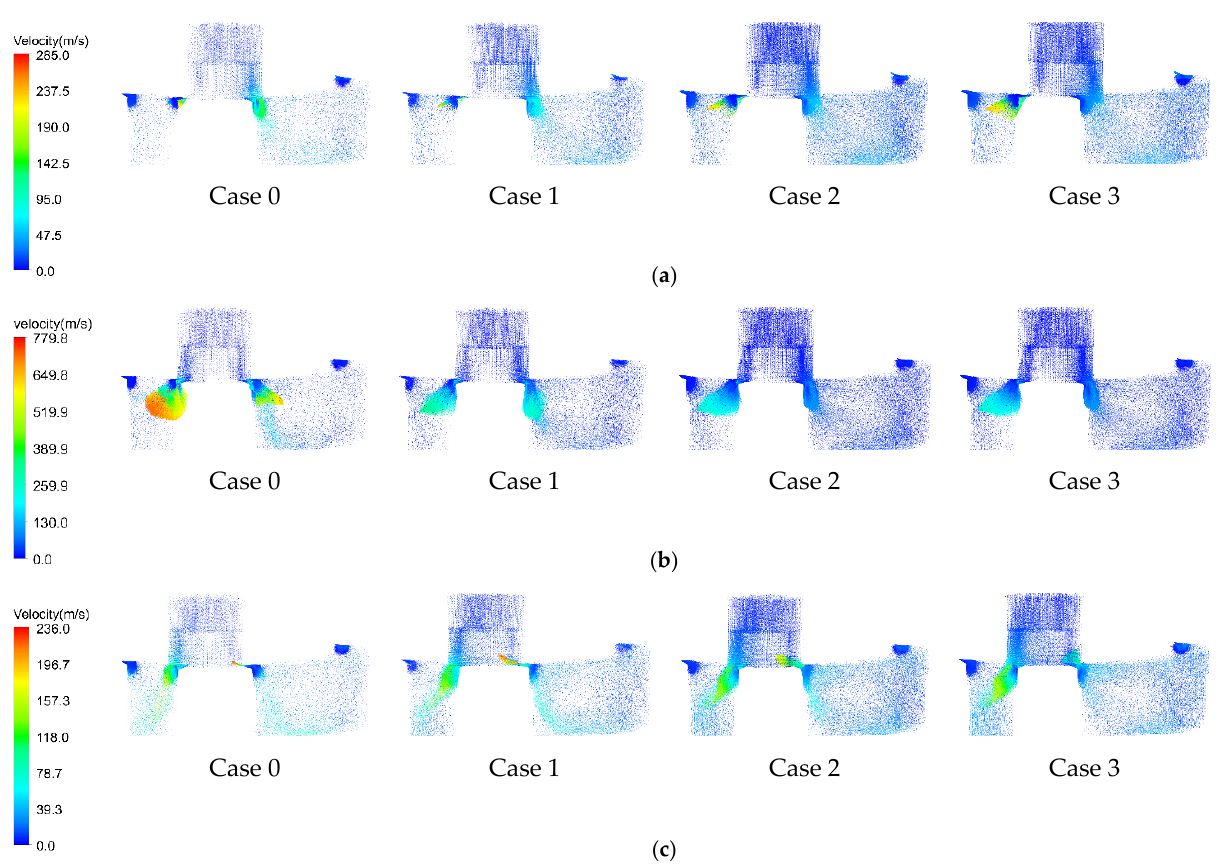
Figure 9. Velocity vector diagram of Case 0–3: Non-dead point transition zone. ( a ) Velocity Vector Diagram of Case 0–3: Non-dead Point Transition Zone at 23 degrees Rotation; ( b ) Velocity Vector Diagram of Case 0–3: Non-dead Point Transition Zone at 27 degrees Rotation; ( c ) Velocity Vector Diagram of Case 0–3: Non-dead Point Transition Zone at 31 degrees Rotation.